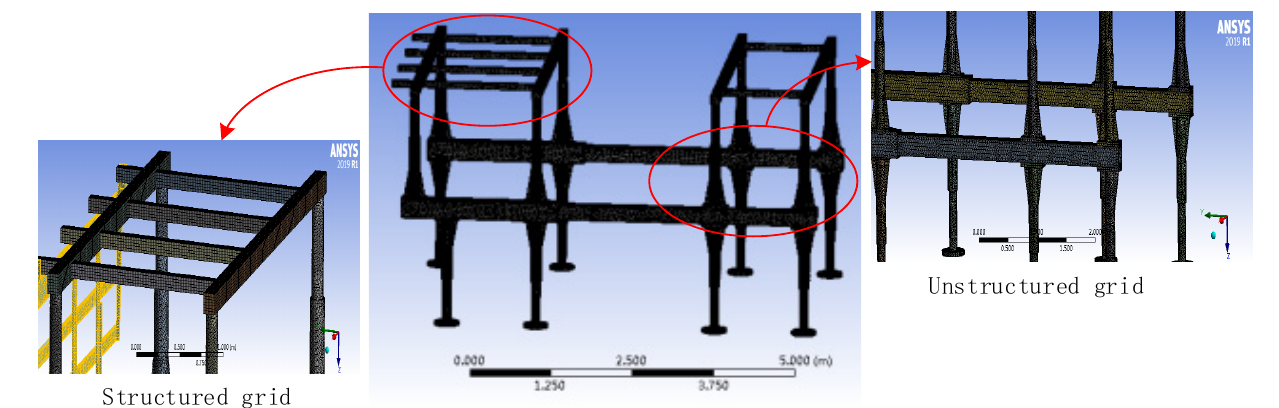
Figure 4. Overall finite element model of the advance support.